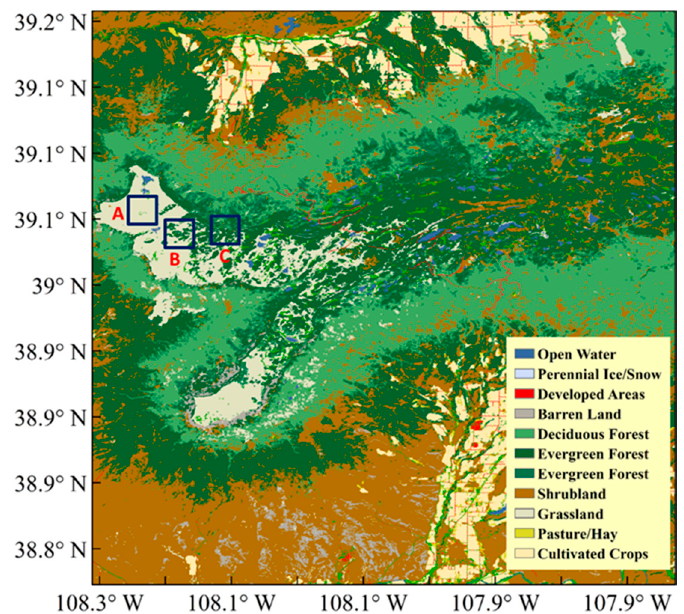
Figure 3. Land cover classification map (USA National Land Cover Data) of the Grand Mesa study region. Boxes A, B, and C (blue outline) delineate grassland, grassland mixed with forest, and forest regions, respectively.